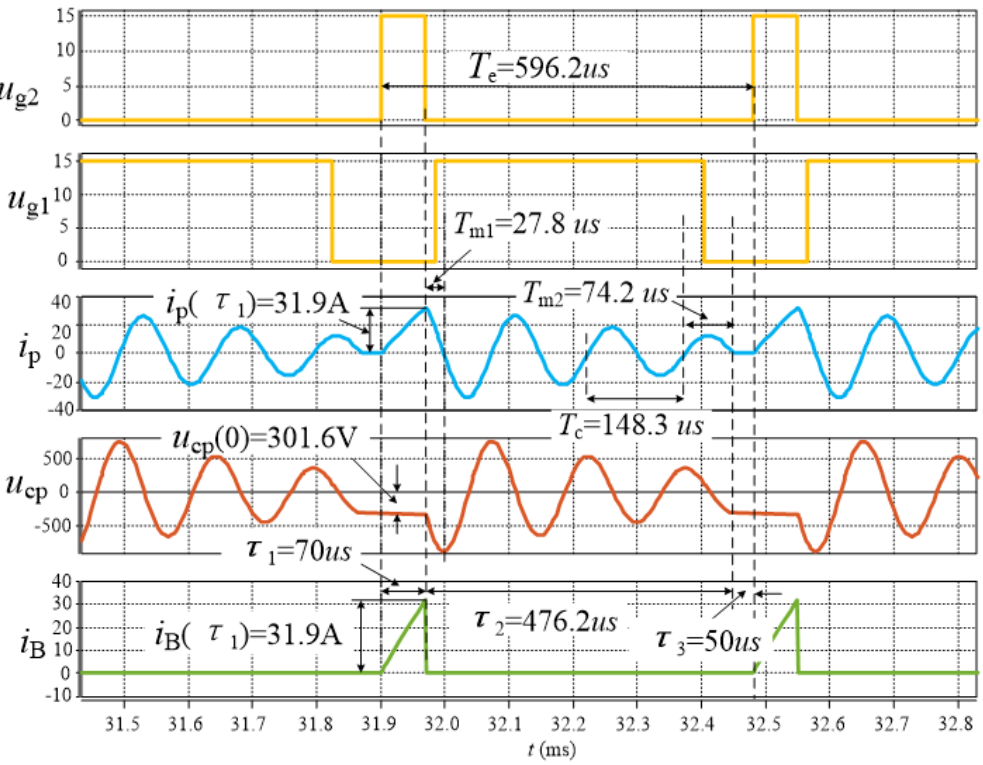
Figure 1. The conceptual schematic of the IIEIFR system. Figure 11. The simulation result of the IIEIFR ICPT system. Figure 11. The simulation result of the IIEIFR ICPT system.